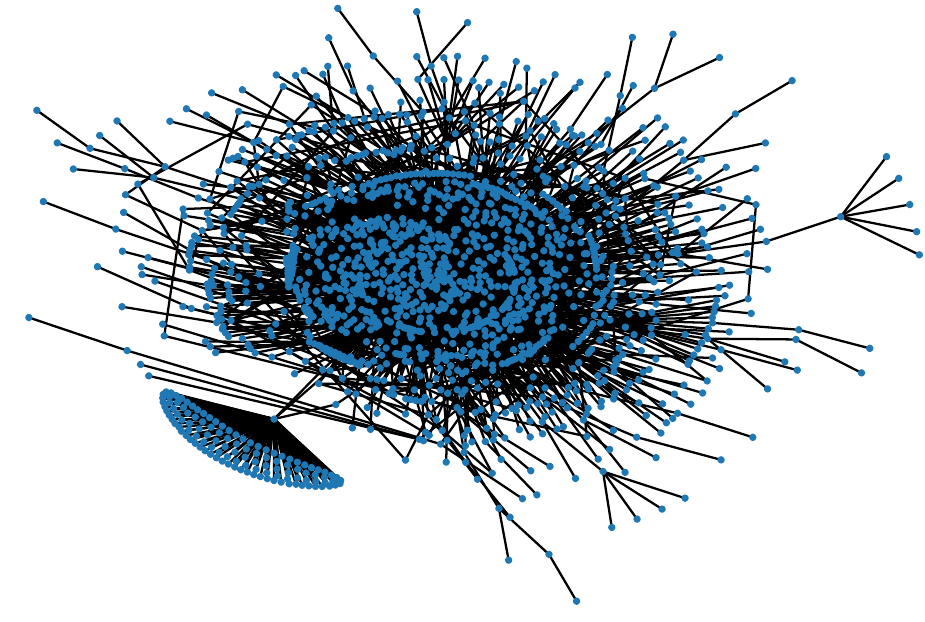
Figure 3. Interaction graph among Twitter users. Each node represents a Twitter account, and each edge represents the interaction between a pair of users. Note that the edge is directed and has a associated frequency-based